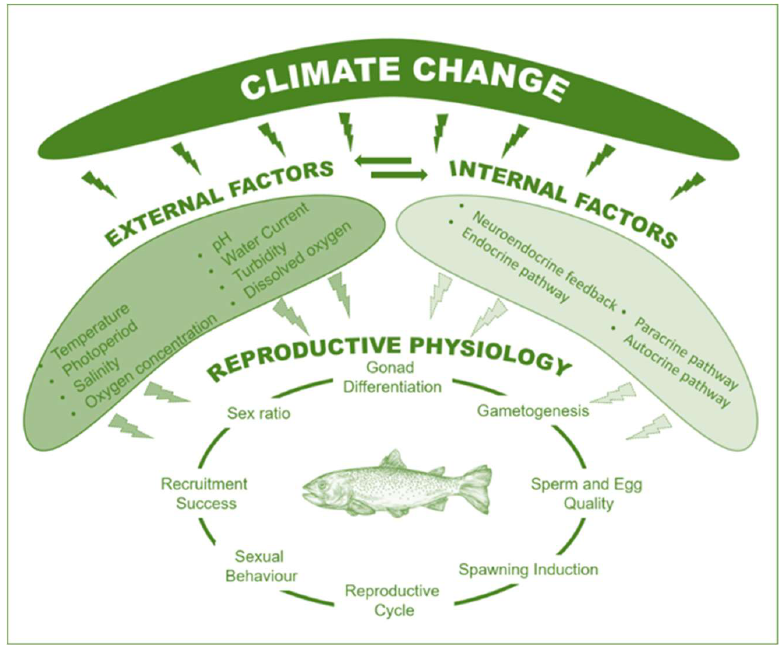
Figure 1. External and internal climate dependent factors affecting fish reproductive physiology.